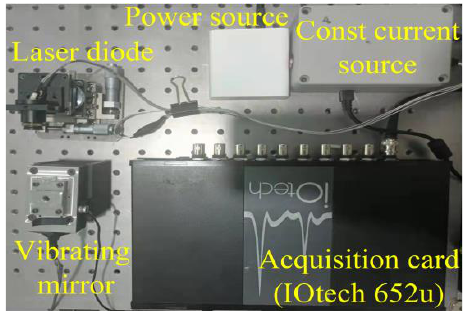
Figure 6. Platform for acquiring SMI microvibration